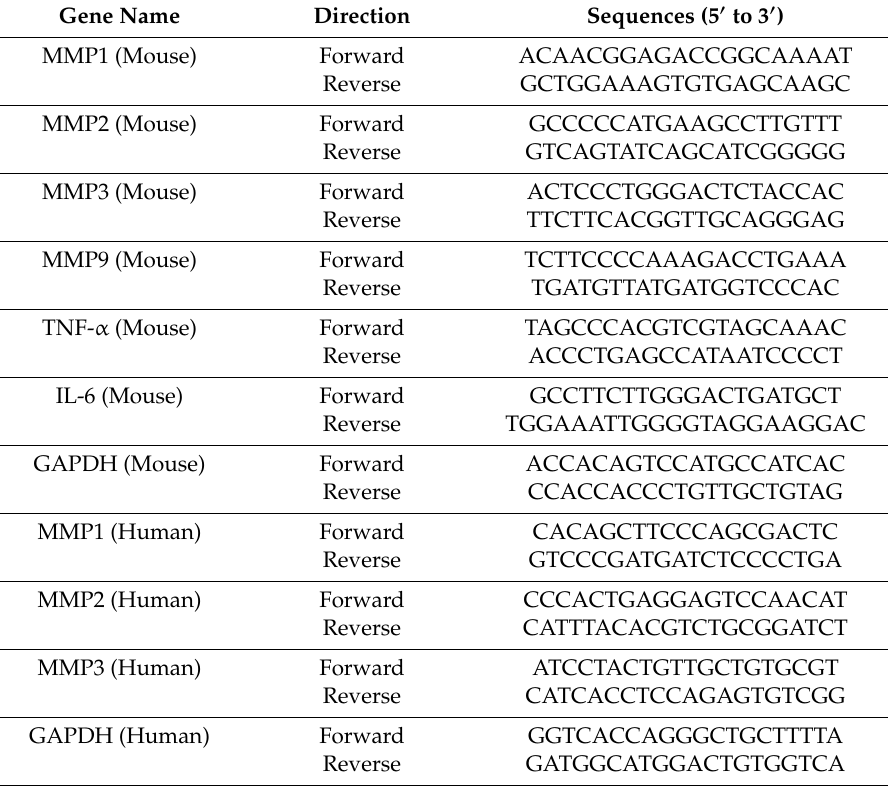
Table 1. The primer sequences for the RT-PCR